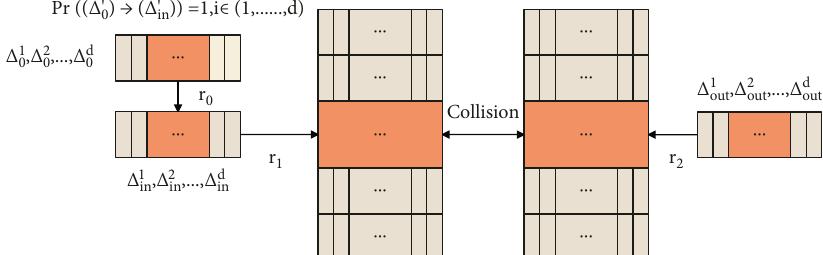
Figure 2: Application of differential enumeration attack on LowMC algorithm. ∗Δ i rounds; r : encryption direction diffusion rounds; r 1